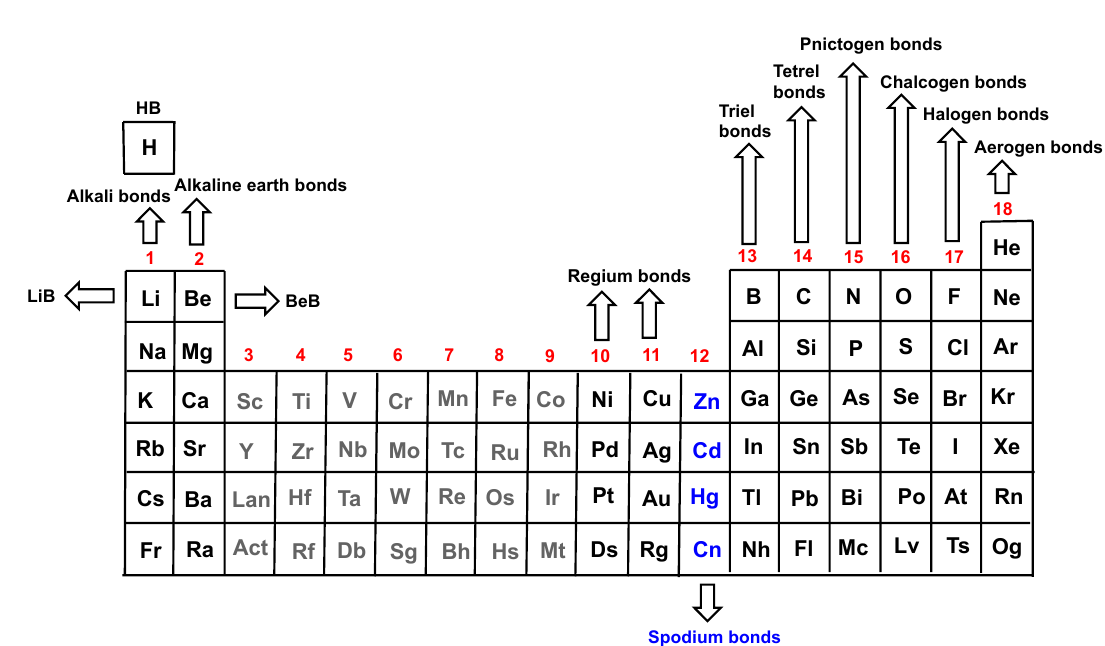
Figure 1. The different noncovalent bonds formed by elements of the Periodic Table. In black are accepted names, and in blue are the proposed new names. Groups 3 to 9 (in grey) are not included in this review.